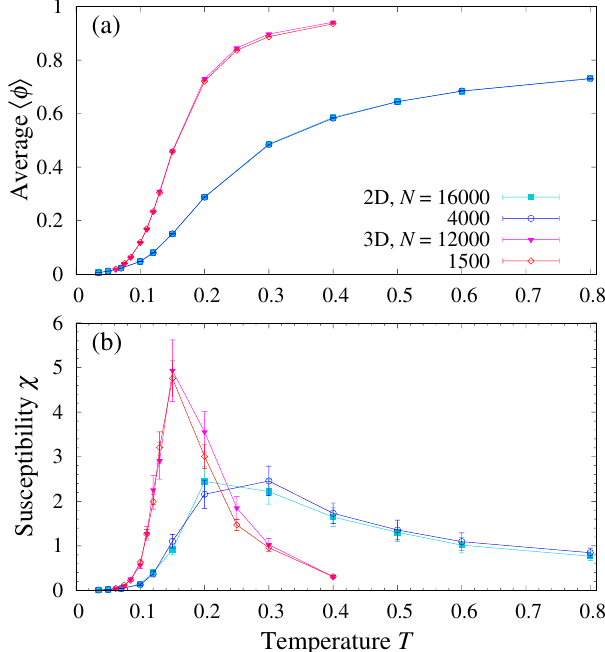
FIG. 4. Soft spheres. (a) Average concentration h ϕ i and (b) collective susceptibility χ of defects, as a function of initial equilibrium temperature. The temperature evolution of the defect concentration is smooth, with a maximum variation near T 0 . 25 and T ≈ 0 . 15 for D ¼ 2 and 3, def